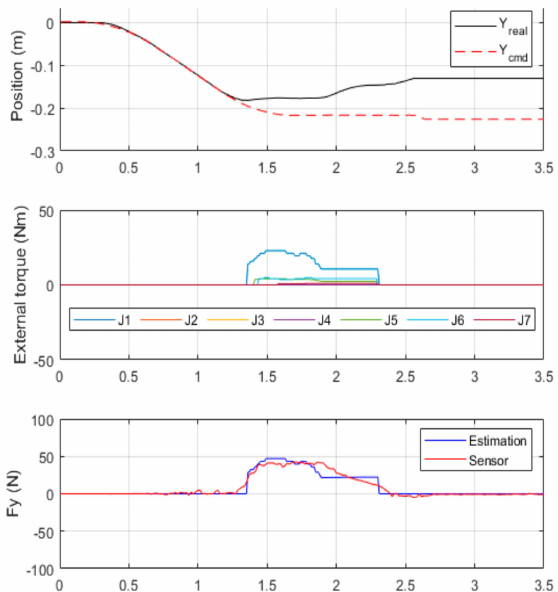
Figure 14. Results of external force detection with a safety controller.